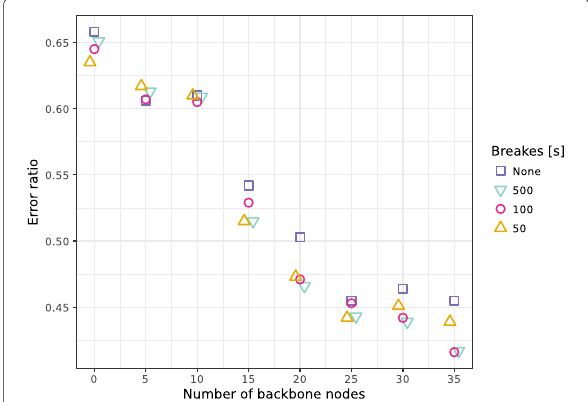
Fig. 8 Impact of different artificially introduced contact durations on the overall